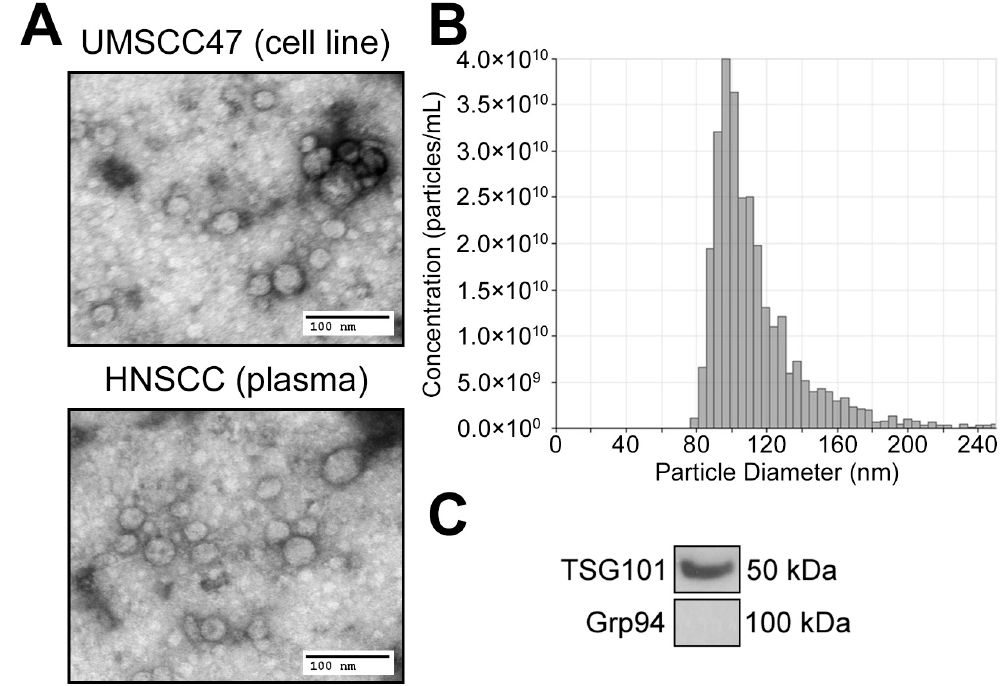
Figure 2. Characterization of exosomes from the supernatant of HNSCC cells or patients’ plasma. ( A ) Representative TEM images of UMSCC47-derived exosomes (upper panel) and exosomes isolated from the plasma of an HNSCC patient (lower panel). ( B ) Representative TRPS (qNano) size and concentration distribution plot of plasma-derived exosomes. ( C ) Western blots of plasma-derived exosomes for exosome marker TSG101 as well as negative marker Grp94 carried by plasma-derived exosomes. Each lane was loaded with 5 µg protein of exosome lysate. The whole blot image can be found in Figure S1.